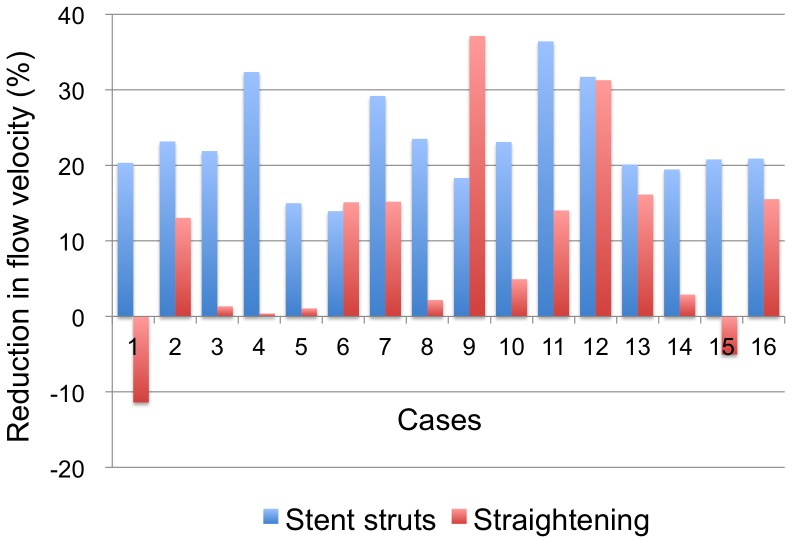
Reduction in flow velocity in 16 cases by either stent struts or straightening of vessels.